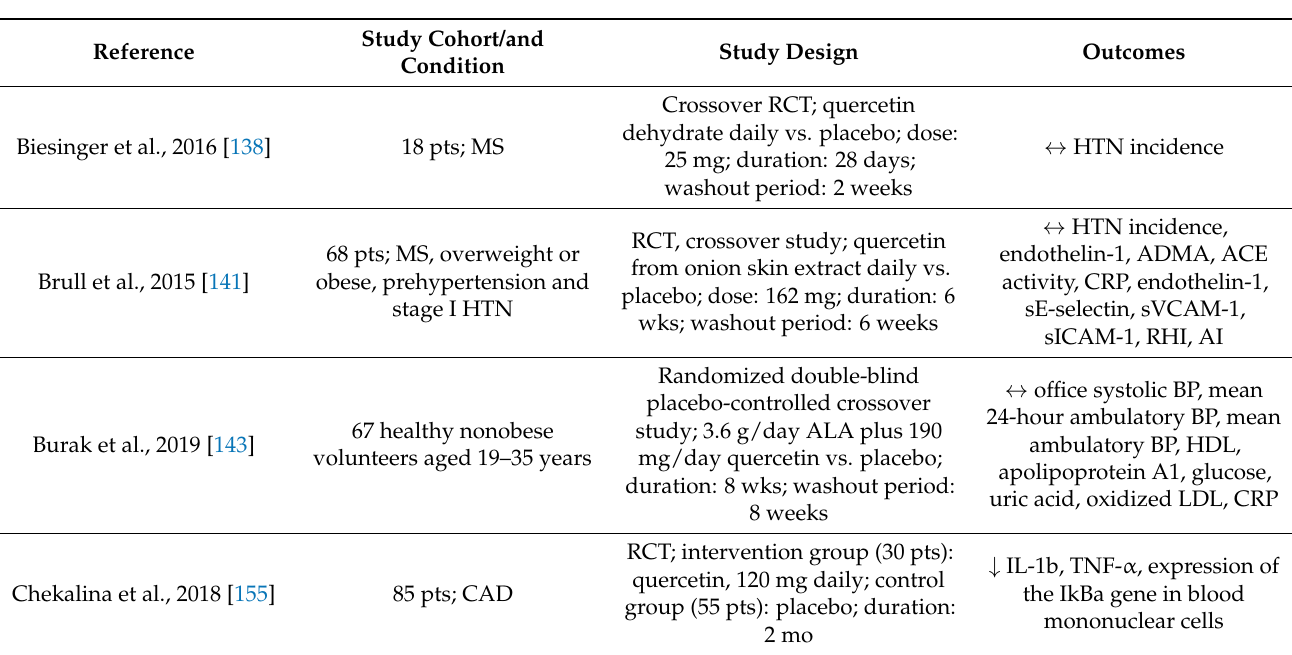
Table 3. Published clinical studies investigating the impact of quercetin on the classical cardiovascular risk factors not included in